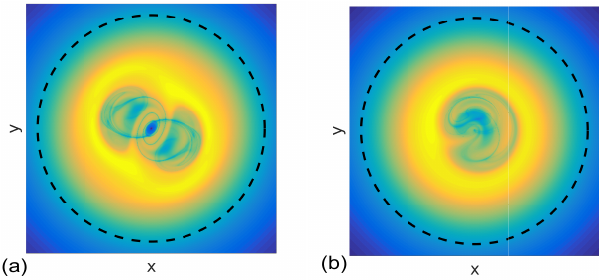
Figure 8. Lagrangian patterns obtained at t = 0 for τ = 15 and dif- ferent parameter settings in the kinematic model. In panel (a) , the model keeps (cid:57) 0 and (cid:57) 2 adjusted to perturb the vortex in its interior part; in panel (b) , the model keeps (cid:57) 0 and (cid:57) 1 adjusted to perturb the vortex in its interior part.